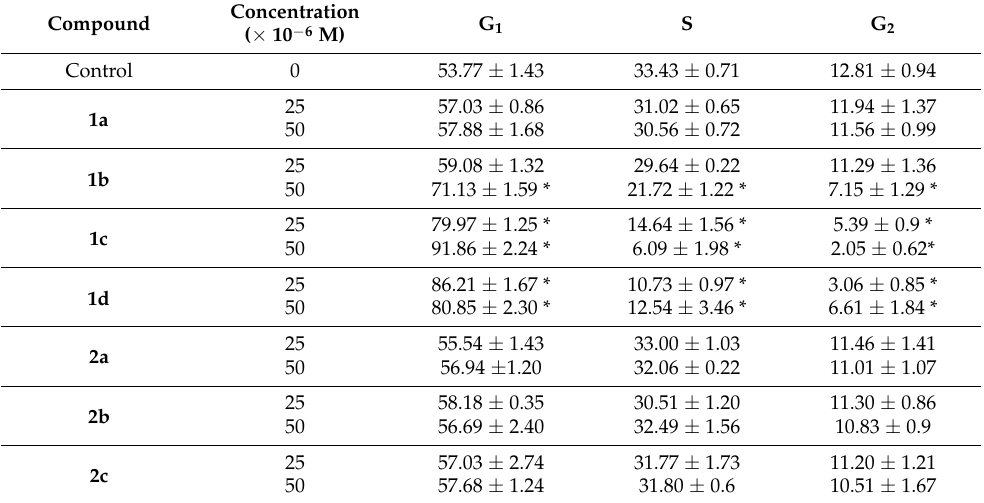
Table 2. Effect of tacrine-coumarin hybrid compounds 1a – 2c on cell cycle distribution.